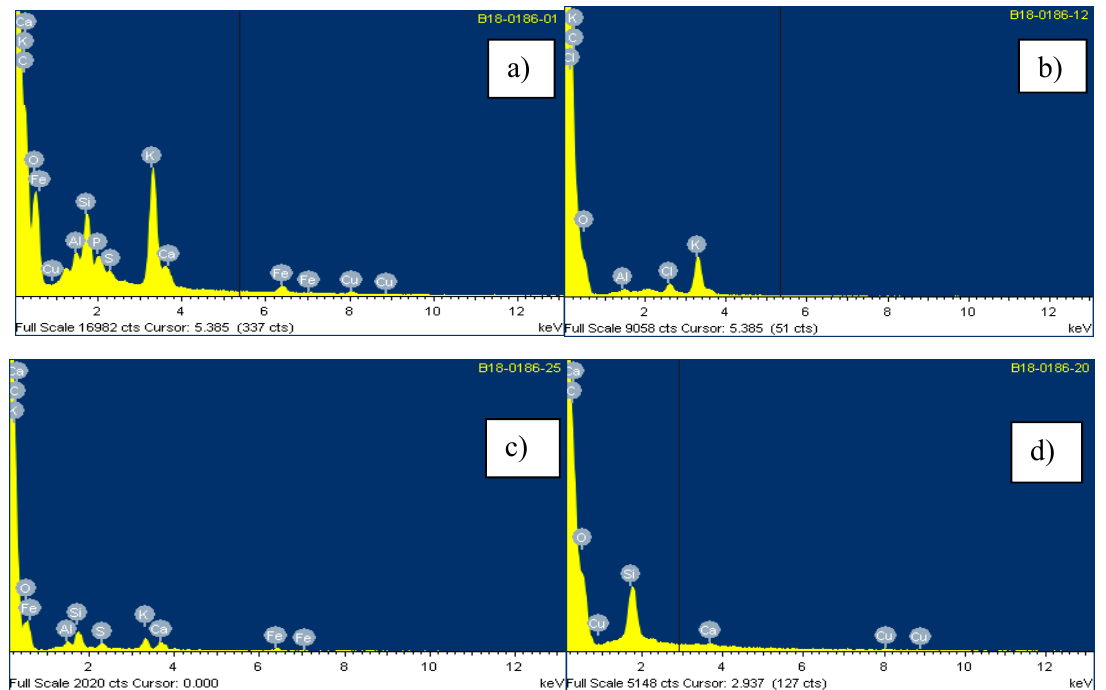
Figure 5. Energy Dispersive X-Ray spectrogram of: ( a ) YP, ( b ) CP, ( c ) BP, and ( d ) OPB biomasses before the adsorption process.